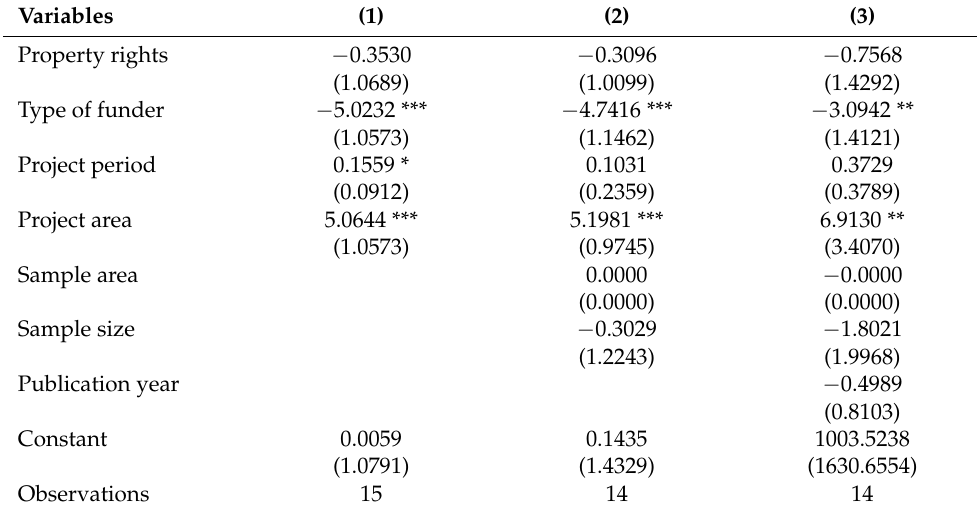
Table 4. The results of PES for environmental